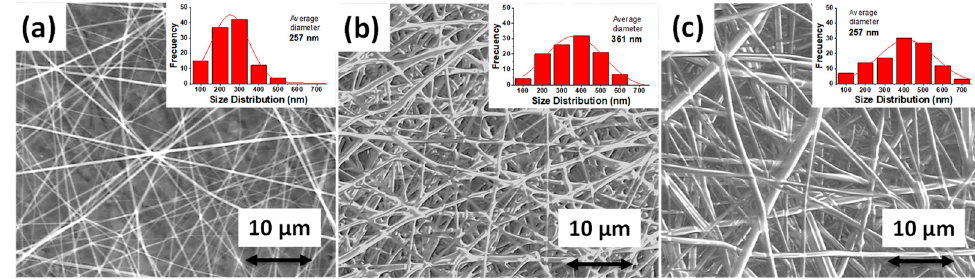
Figure 3. SEM images of ( a ) PVP nanofibers, ( b ) RPET/PVP nanofibers, and ( c ) RPET/PVP/ST nano-